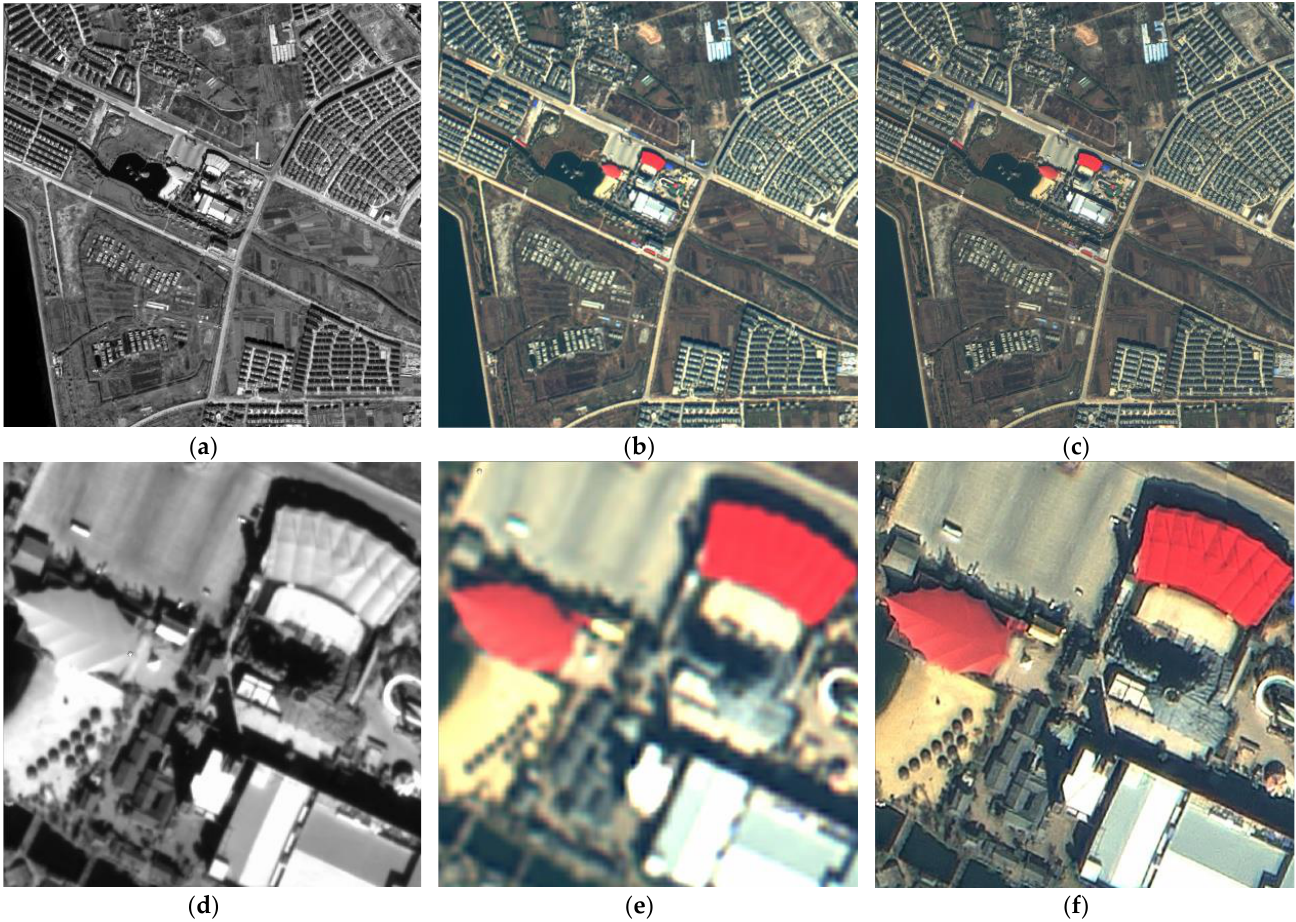
Figure 8. Panchromatic product of ROI in ( a ) and detail in ( d ), Multispectral product of ROI in ( b ) and detail in ( e ), Fusion product of ROI in ( c ) and detail in ( f ).